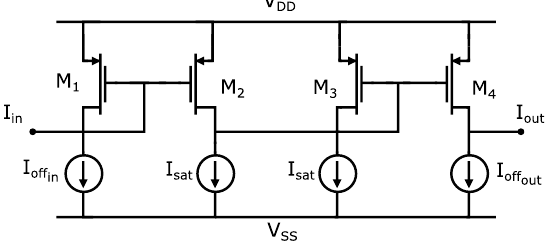
Figure 14. CMOS design of the SNLF block taken from [36].